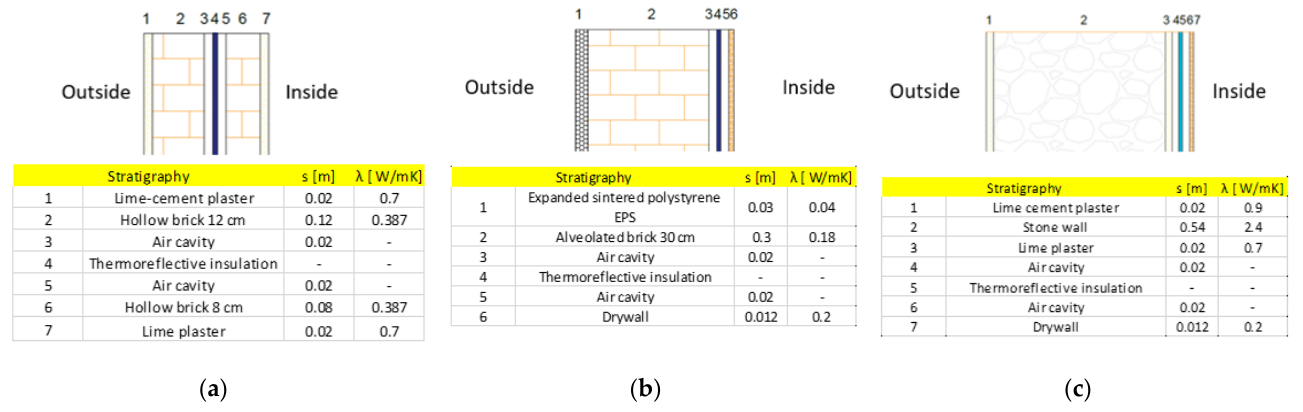
Figure 1. Kinds of walls investigated in the present work to simulate the contribution of the reflective insulator with the assumed conductivities for the different layers. ( a ) Cavity wall; ( b ) Brick wall; ( c ) Stone wall.